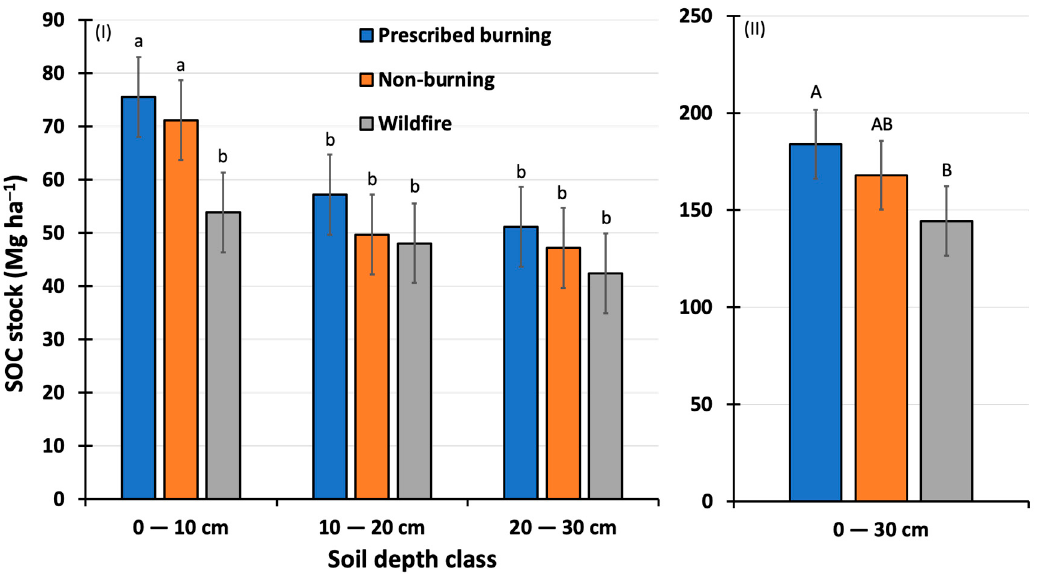
Figure 5. Soil organic carbon (SOC) stocks (Mg C ha − 1 ) among prescribed burning, non-burning, and wildfire sites at different depth classes (I), and the sum of SOC stocks down to 30 cm depth (II). Error bars denote 95% confidence intervals. Different letters above bars indicate significant differences (Tukey p < 0.05) between burning types within the same soil depth